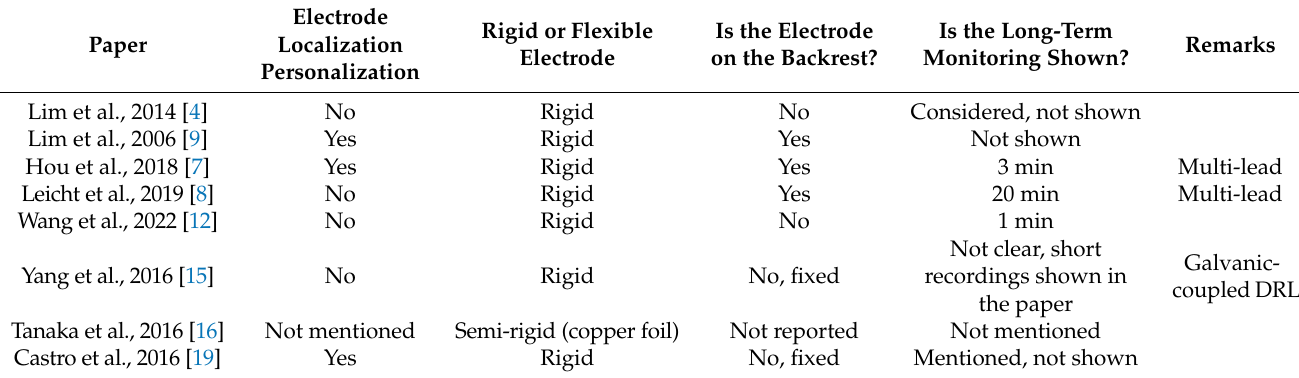
Table A1. Information on the selected properties of the embedded cECG